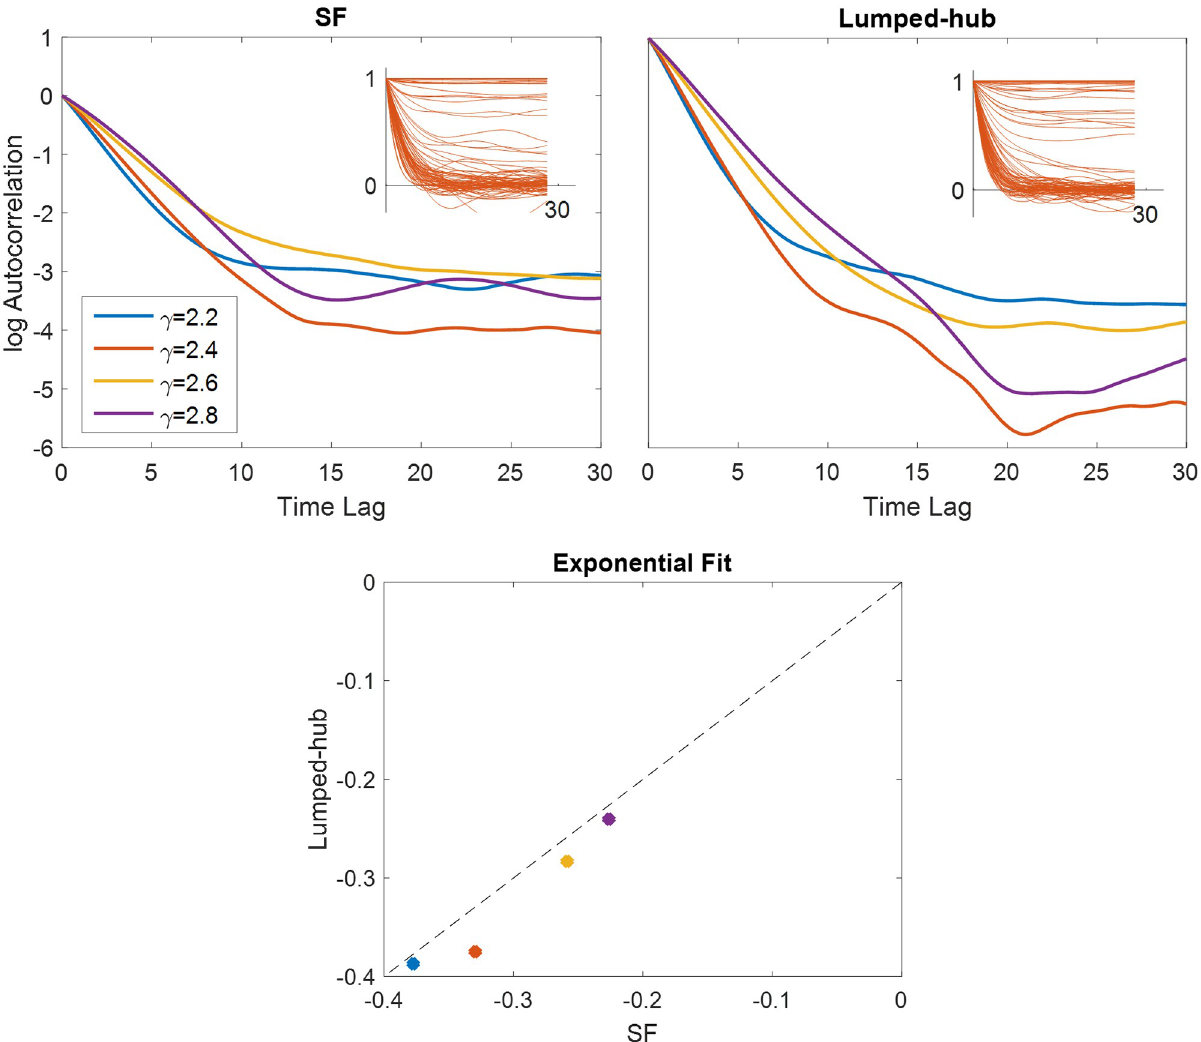
Fig 10. Autocorrelation of SFO ensembles vs. their lumped hub approximation. Top : Log of mean autocorrelation is shown for scale free (left) and corresponding lumped-hub (right) networks. The mean is obtained by averaging only over trajectories with asymptotic autocorrelation below 0.3. Insets show 100 individual trajectories obtained for γ = 2.4. Bottom : Exponential fits for the autocorrelation functions in the range 0 � t � 5 ( γ color coded accordingly to the top panel.